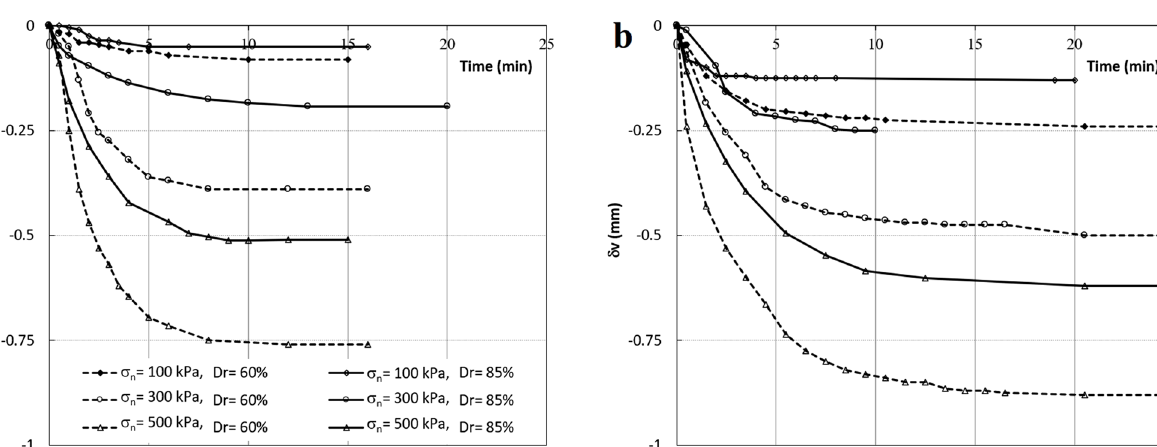
Figure 4. Typical curves for the dry test and dry followed by wetting. ( a ) Shear stress–shear displacement. ( b ) Vertical displacement-shear displacement.